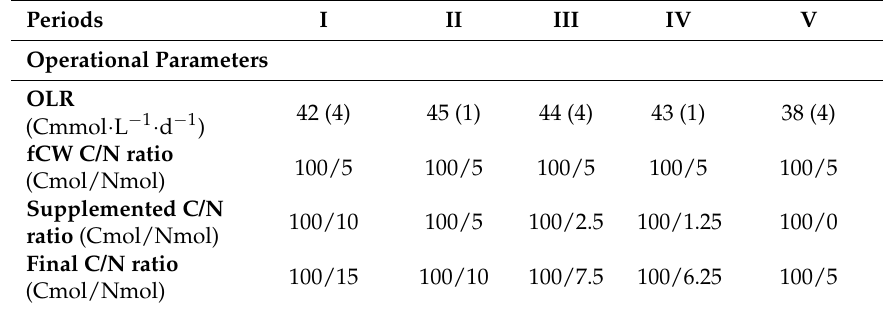
Table 2. Summary of the operational parameters applied to the selection SBR on the five different periods. Periods I II III IV V Operational Parameters